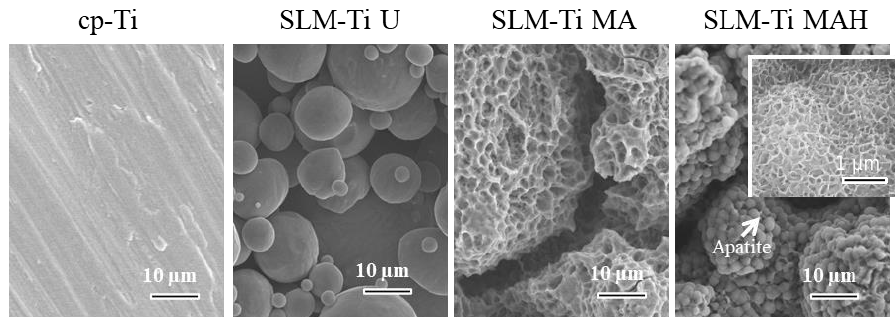
Figure 5. SEM images of cp-Ti and SLM-Ti after soaking in SBF for 1 day. Inserted window shows high magnification image. Only SLM-Ti MAH was subsequently covered by the apatite layer.